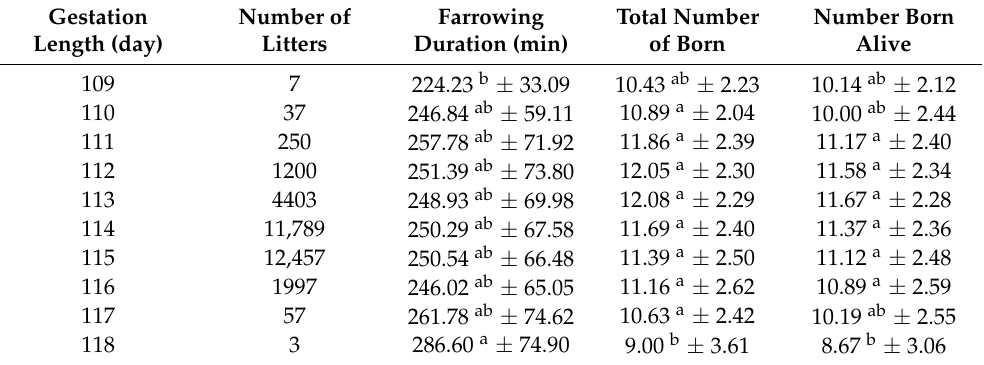
Table 7. Descriptive statistics of farrowing duration and litter size of different gestation